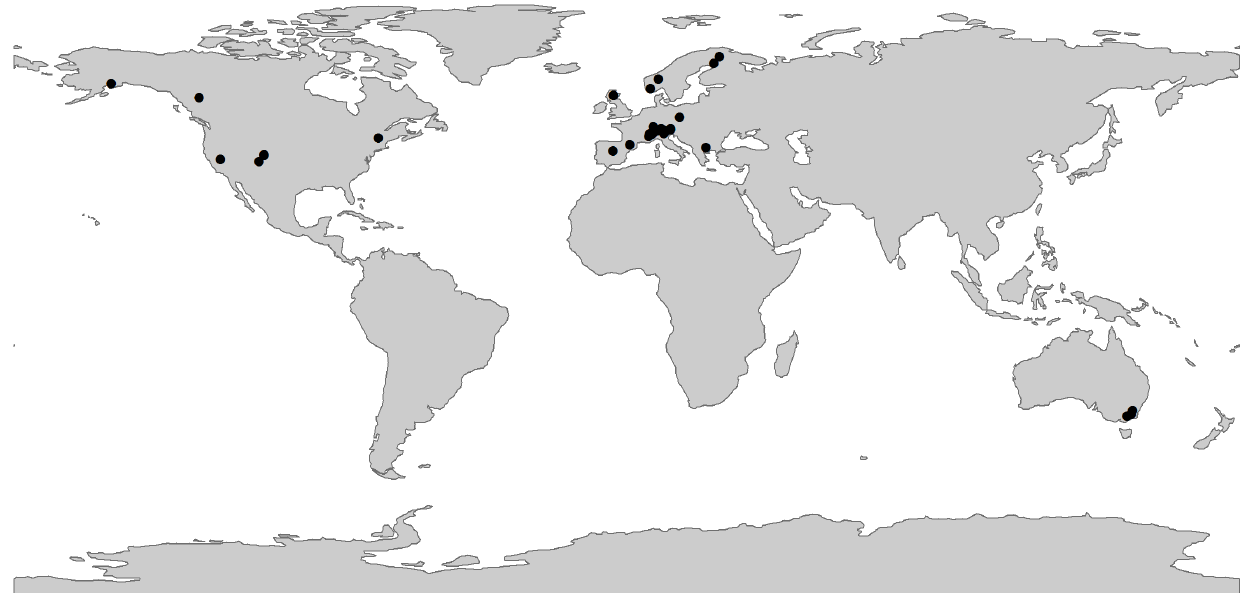
Figure 1. Global distribution of studies (n=41) that investigated the effects of winter recreation on wildlife.